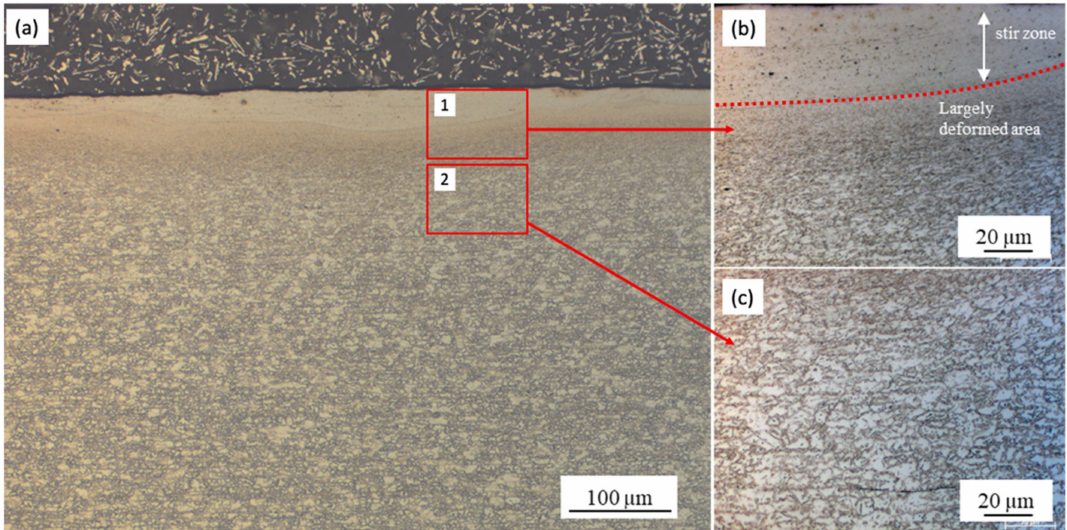
Figure 6. ( a ) OM image near the top surface of a sample with condition A (Location “X” in Figure 4b) showing di ff erent states of microstructures; ( b ) magnified optical images at location “1” showing SZ (red dotted line) and largely deformed area near top surface; and ( c ) magnified optical image at location “2” showing mixture of ferrite and martensite microstructures.